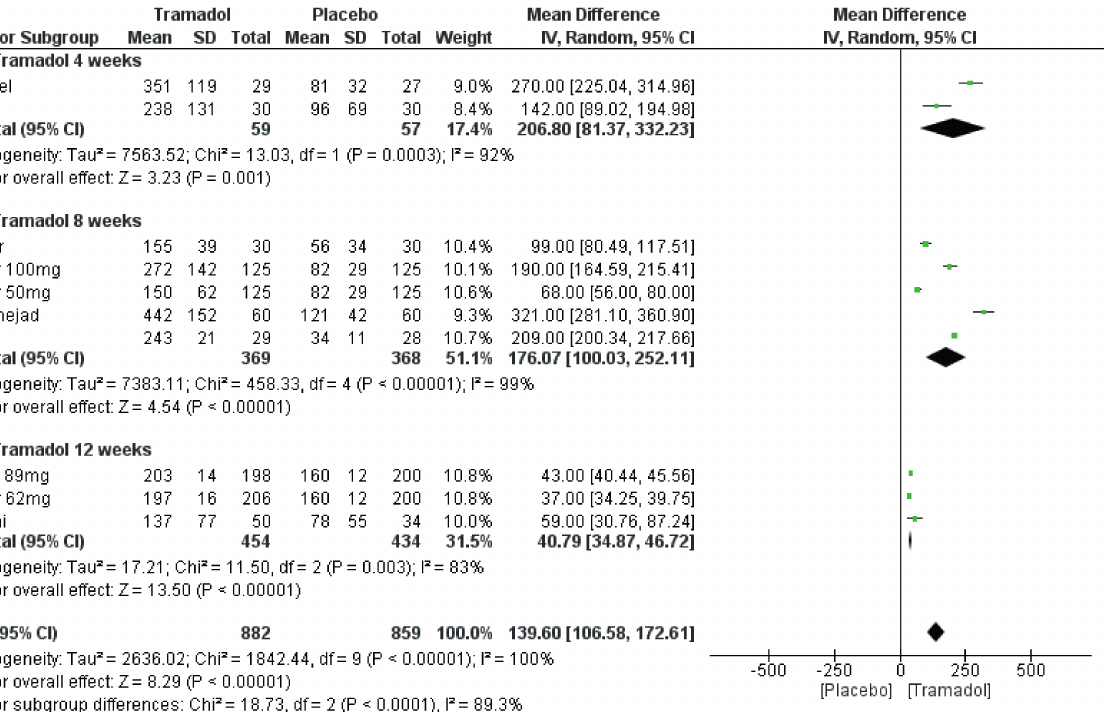
Figure-4 - Forest plot depicting comparison of various durations of Tramadol use in premature